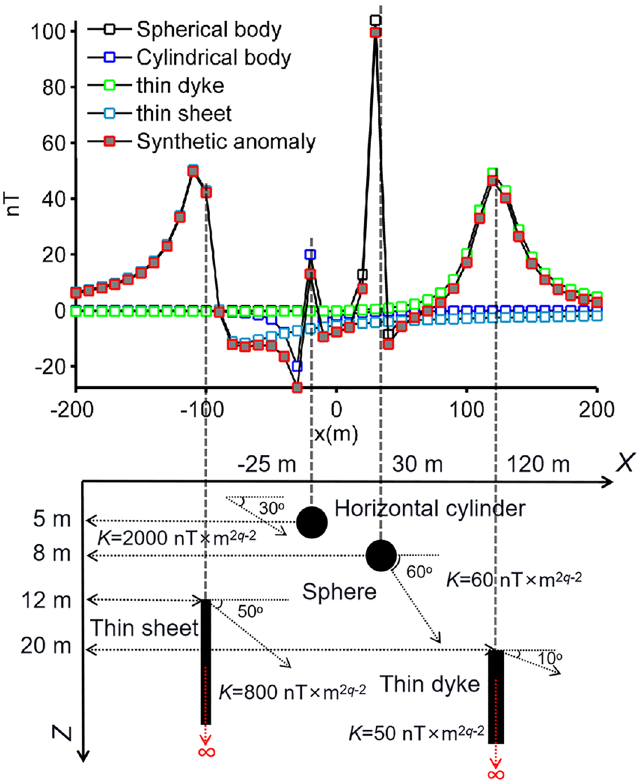
Figure 5. Simulated magnetic anomaly of multiple-source and the causative subsurface